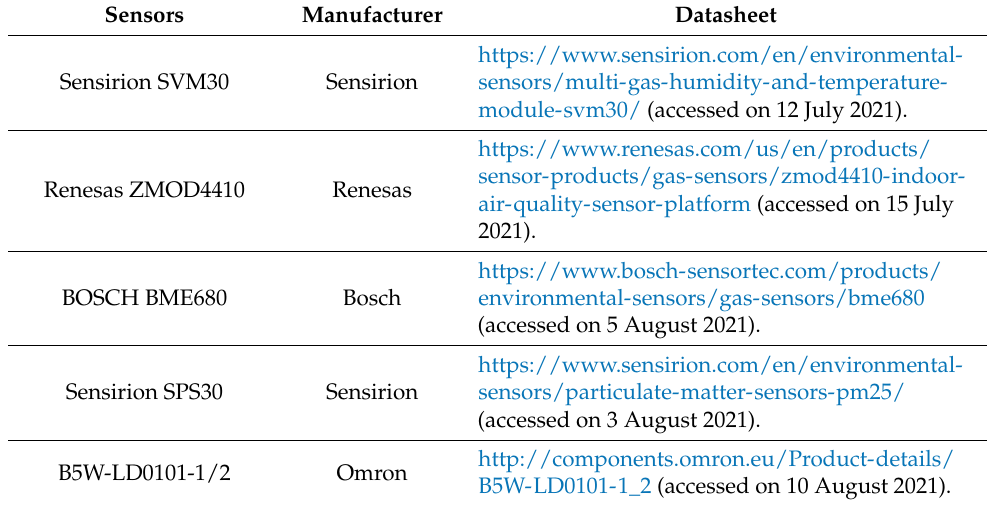
Table 1. Sensors for IAQ measurements.